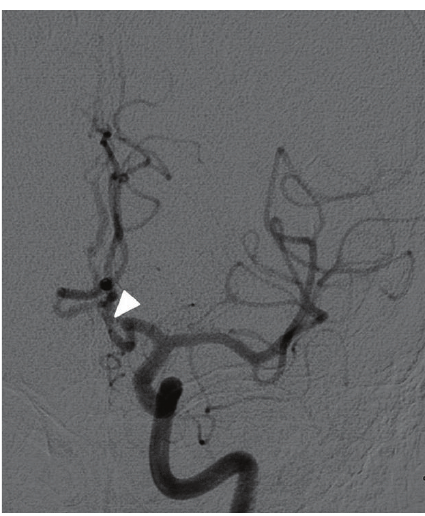
Figure 1: Left internal carotid injection. The arrowhead shows an azygous A2 from which both the pericallosal arteries arise.